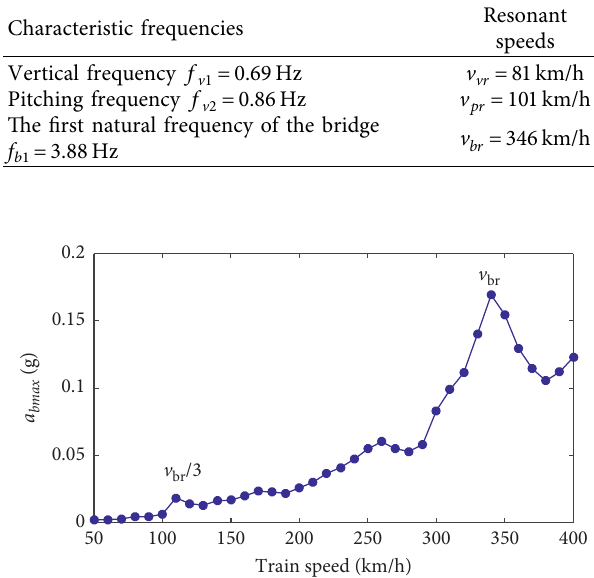
Figure 4: Maximum midpoint accelerations of the bridge versus train speed.